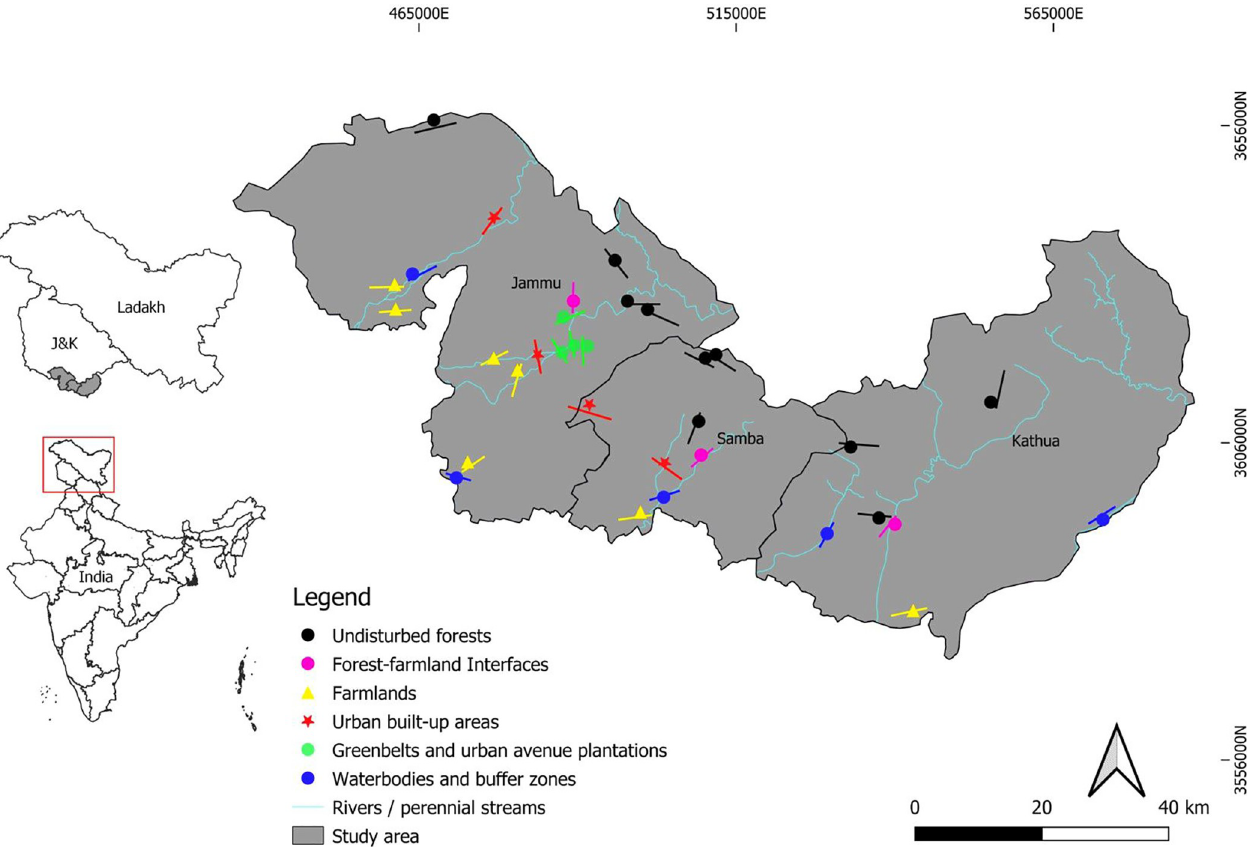
Fig 1. Location of sampling sites in the study area. The colored lines denote the sample clusters for each habitat type, which include road and line transects, while the symbols represent vantage points (refer S1 Appendix for details). All the spatial attributes were collected and prepared by the authors for the visualization purpose using open source QGIS; no copyrighted material was